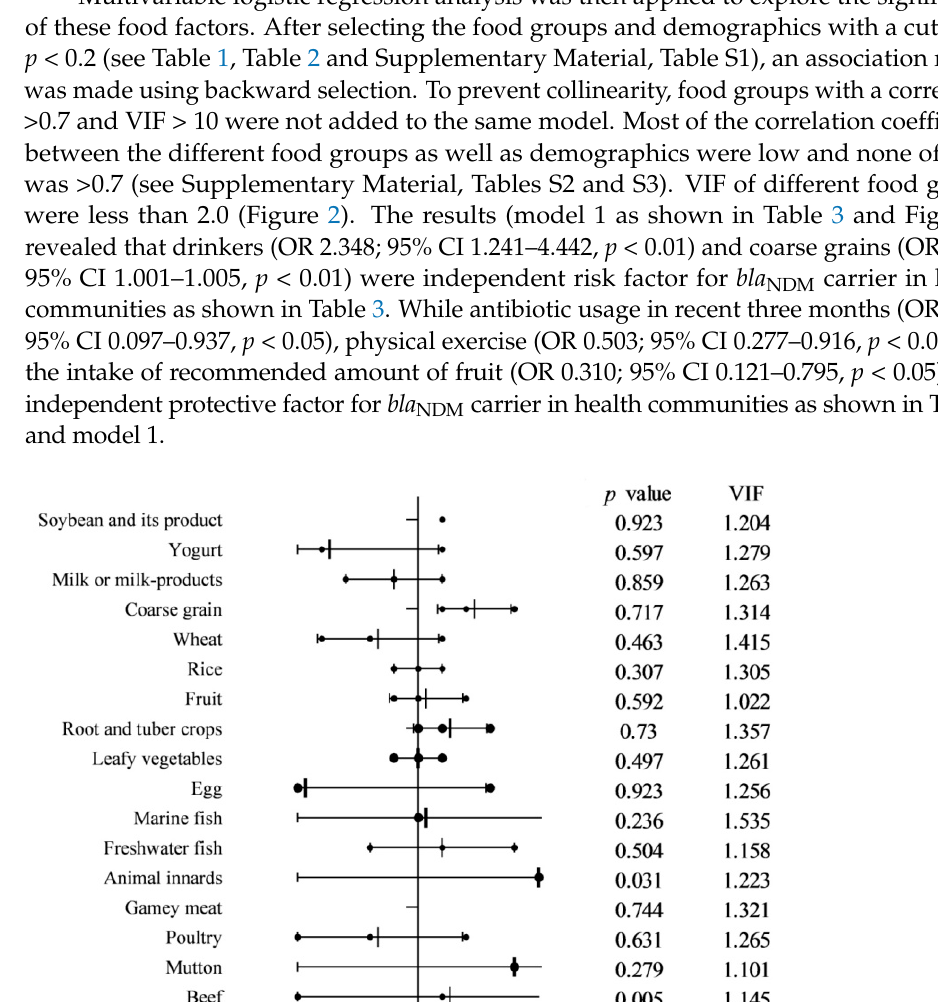
Table 1. * p < 0.05, ** p < 0.01 significantly associated with prevalence of bla NDM carrier.